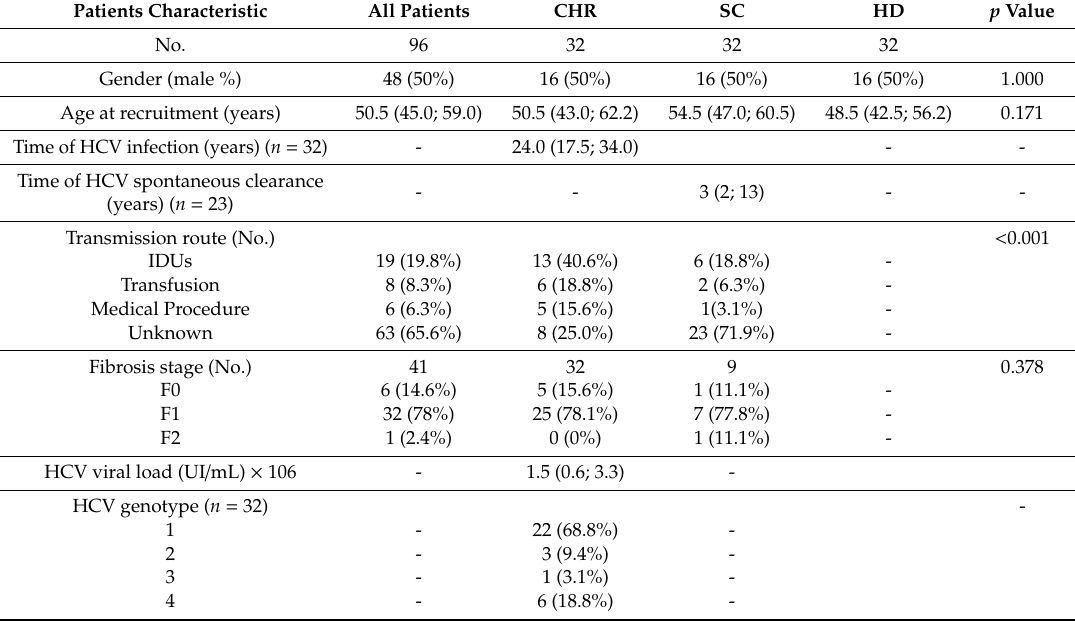
Table 1. HCV-related clinical and epidemiological characteristics of 96 patients with miRNA sequencing